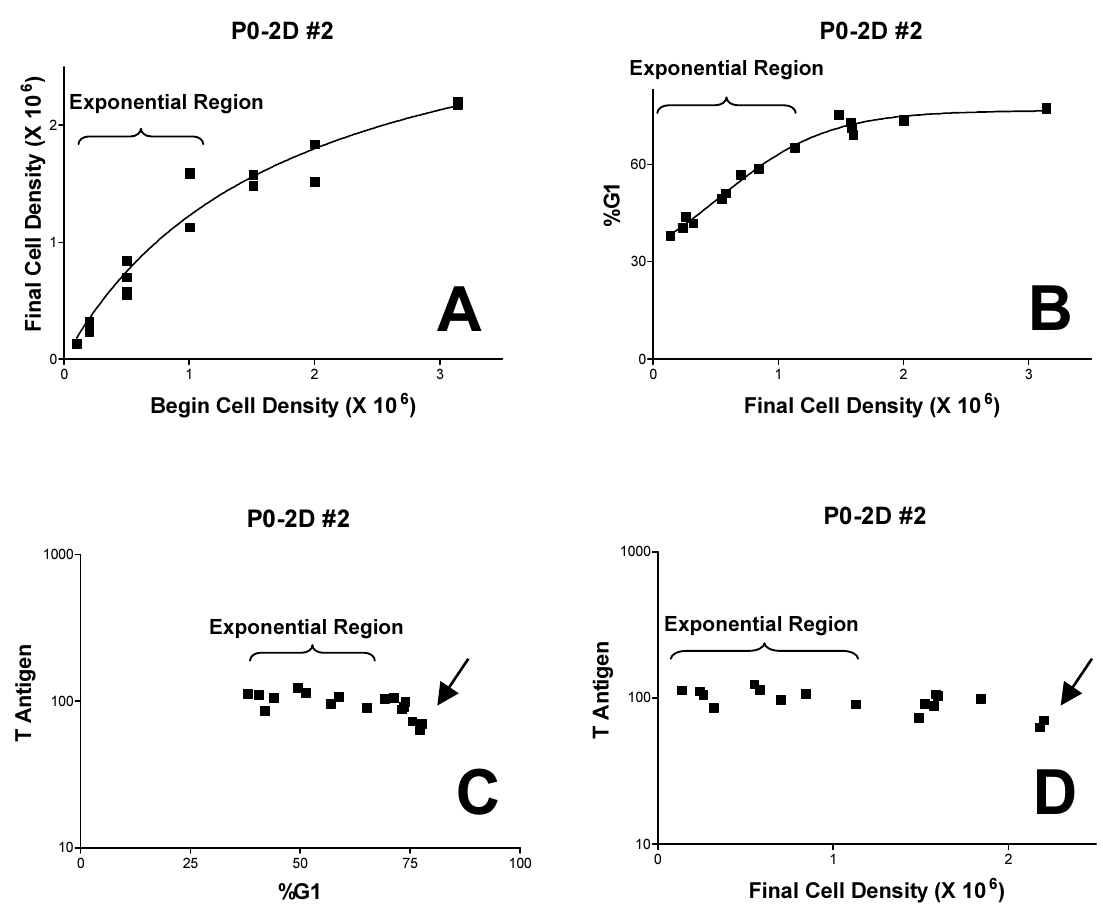
Figure 5 Representative cell cycle and cell density-related changes in Tag. Panel A shows the final cell density versus the initial plating density. Data representing cells in exponential growth are expected to fit an approximate straight line. Data that fall below an extrapolation of that line are at or are approaching density arrest. Panel B shows that the fraction of cells in G 1 increases as a function of density during exponential growth and plateaus as cells arrest. Panels C and D show the G expression as a function of the fraction of G 1 cells (C) or cell density (D). The regions of data used to calculate the rate of change in expression by linear regression are delineated (brackets) and the data used to determine the terminal expression lev- els are marked